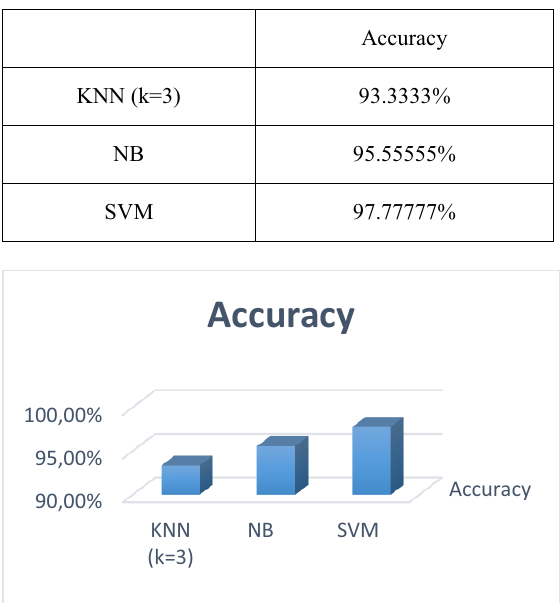
Fig. 7. Comparison of classifiers’ performance on